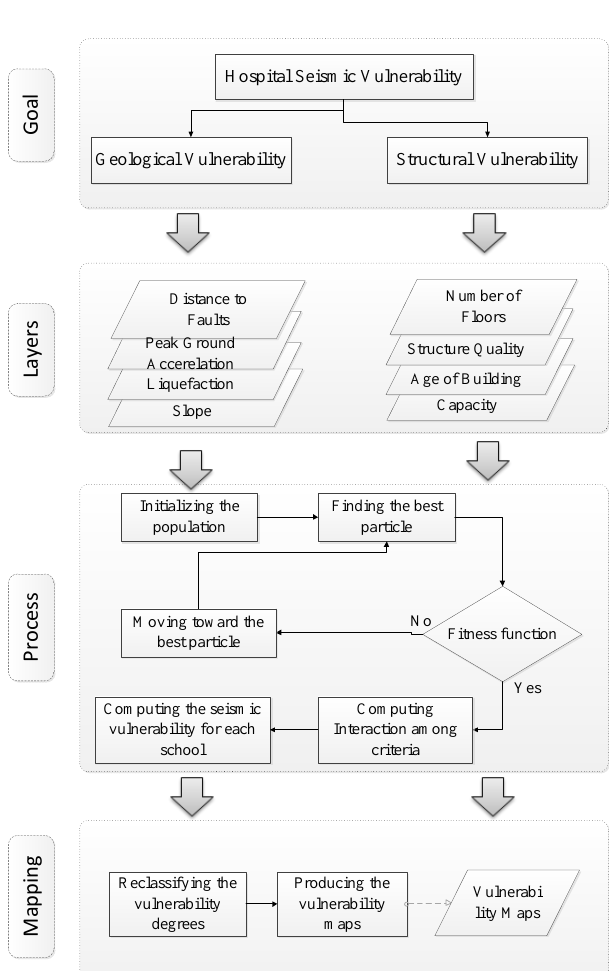
Figure 2. The steps of the proposed model